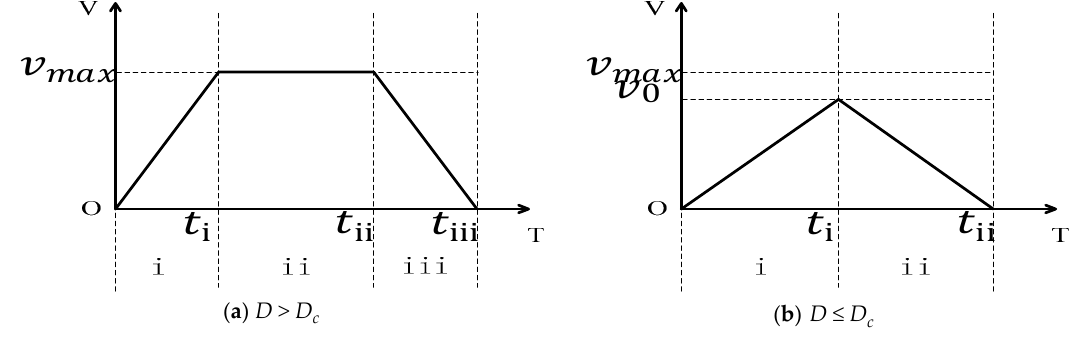
Figure 4. Operating process of the equipment.